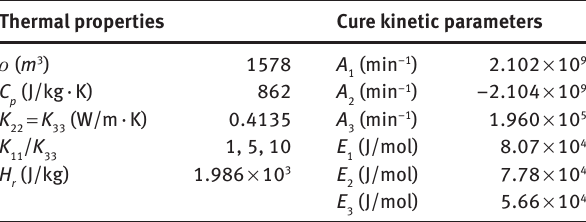
Table 1: Thermal properties and cure kinetic parameters for graphite/epoxy.